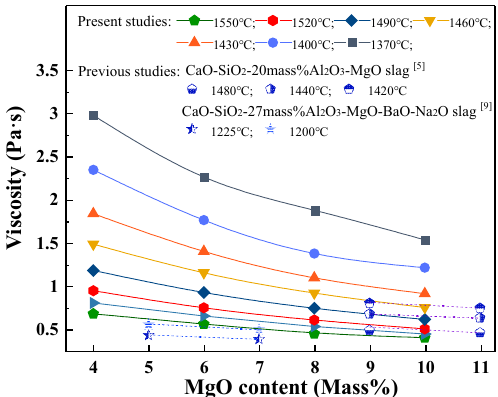
Figure 3. MgO content dependence on the viscosity of the slags at the temperature between 1370 °C and 1550 °C.